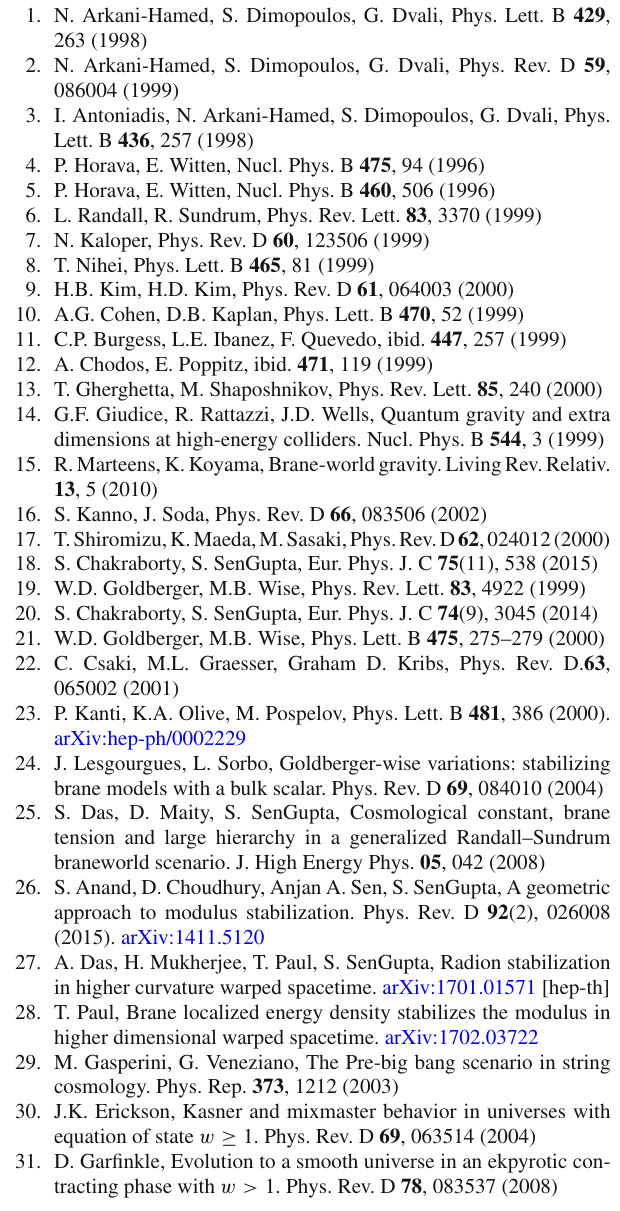
Fig. 4 ρ eff , ρ cur , ρ rad and ρ coup vs. t for B = 1, D = 0 .